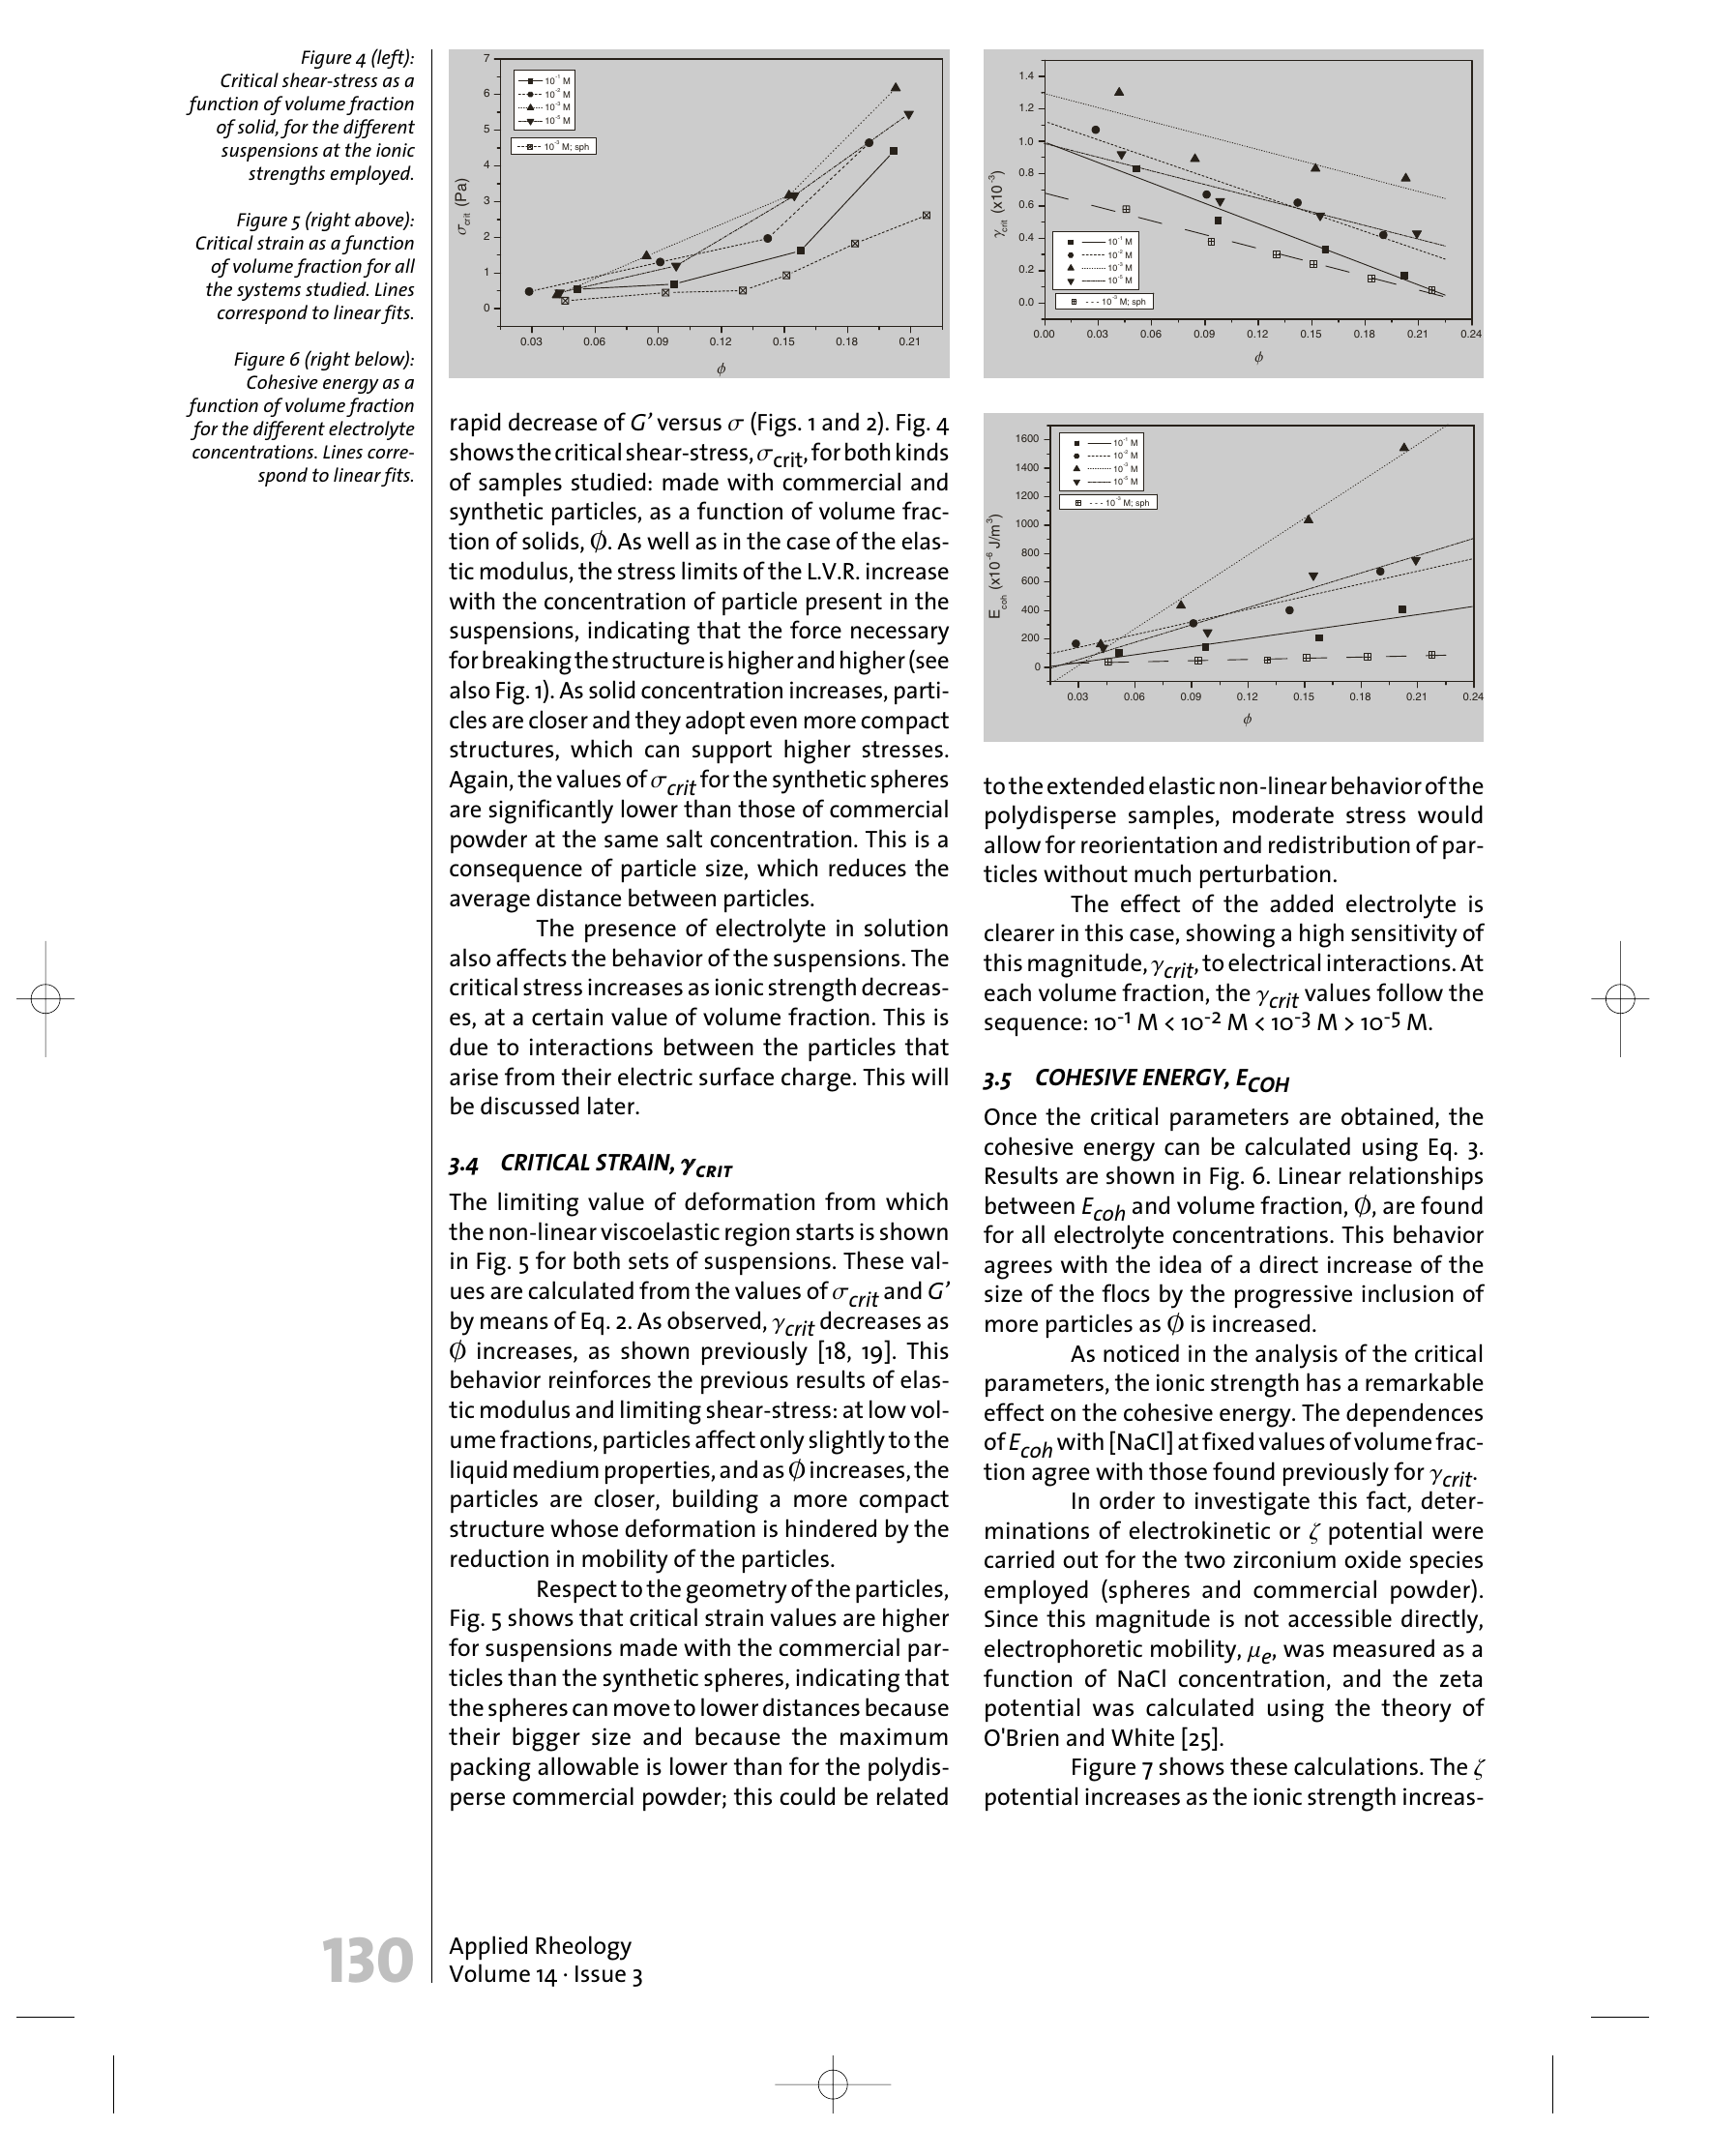
Figure 4 (left): Critical shear-stress as a function of volume fraction of solid, for the different suspensions at the ionic strengths employed. Figure 5 (right above): Critical strain as a function of volume fraction for all the systems studied. Lines correspond to linear fits. Figure 6 (right below): Cohesive energy as a function of volume fraction for the different electrolyte concentrations. Lines corre- spond to linear